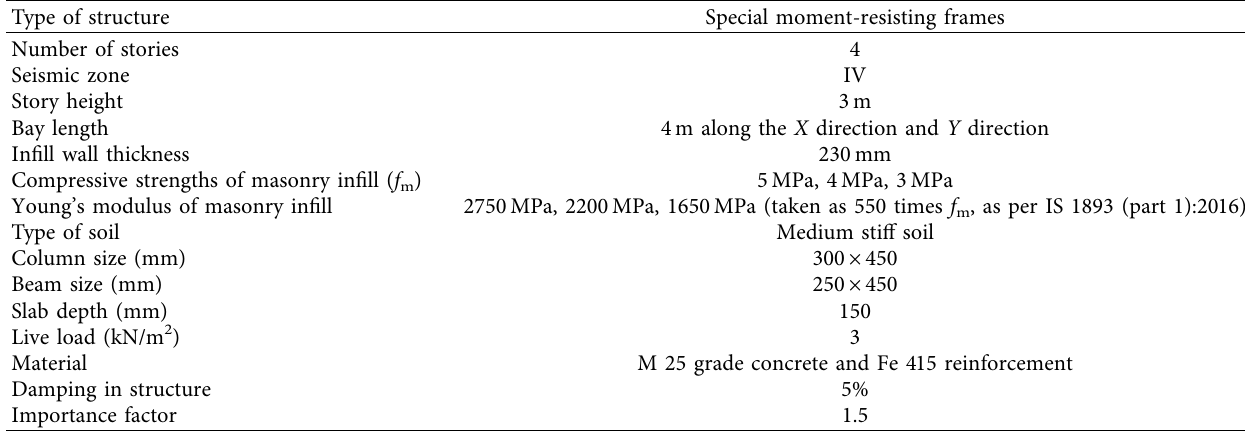
Table 3: Material and sectional properties of models for structural analyses.